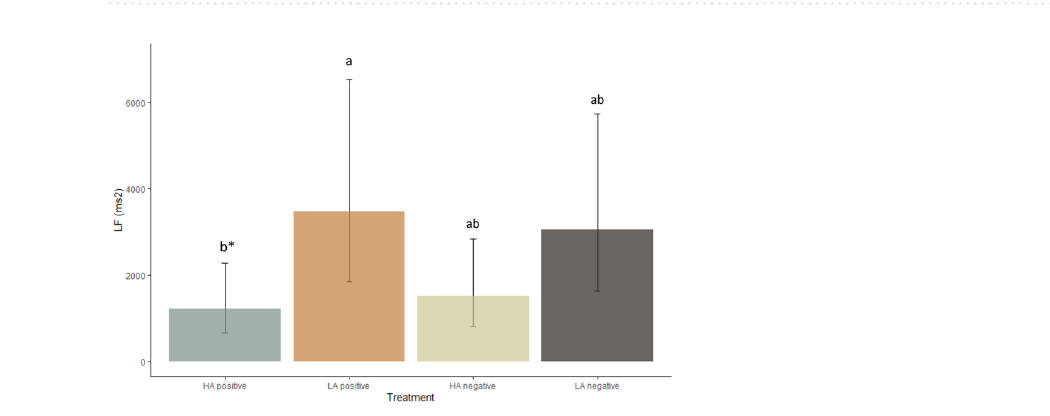
Figure 7. Effect of emotional treatment (Table 2) on heart rate variability indexes (mean ± CI), with ( a) HR, ( b) RR, ( c) SDNN and ( d) RMSSD. HA high arousal, LA low arousal. Bars that do not share the same letter are significantly different from each other (P < 0.05), Asterisk indicates a tendency for a difference (P < 0.1).